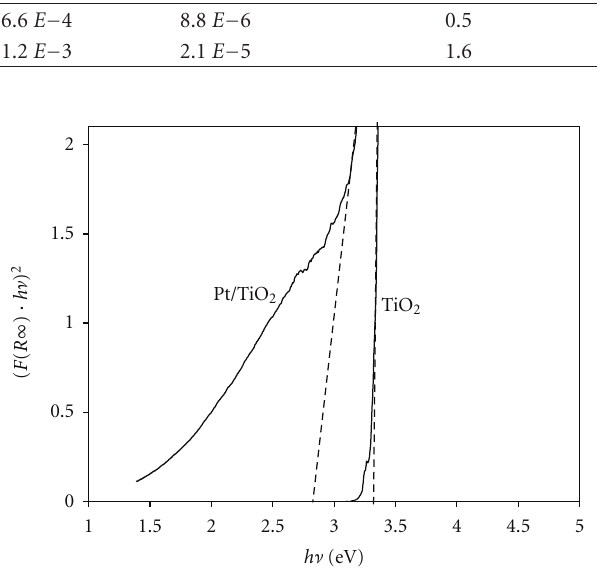
Figure 4: Band gap calculus from UV-Vis DRS spectra for TiO 2 and Pt/TiO 2 catalysts.